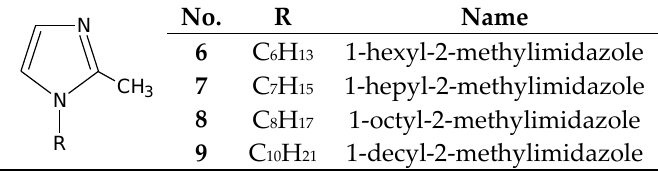
Figure 3. The 1-alkyl-2-metylimidazole molecule.